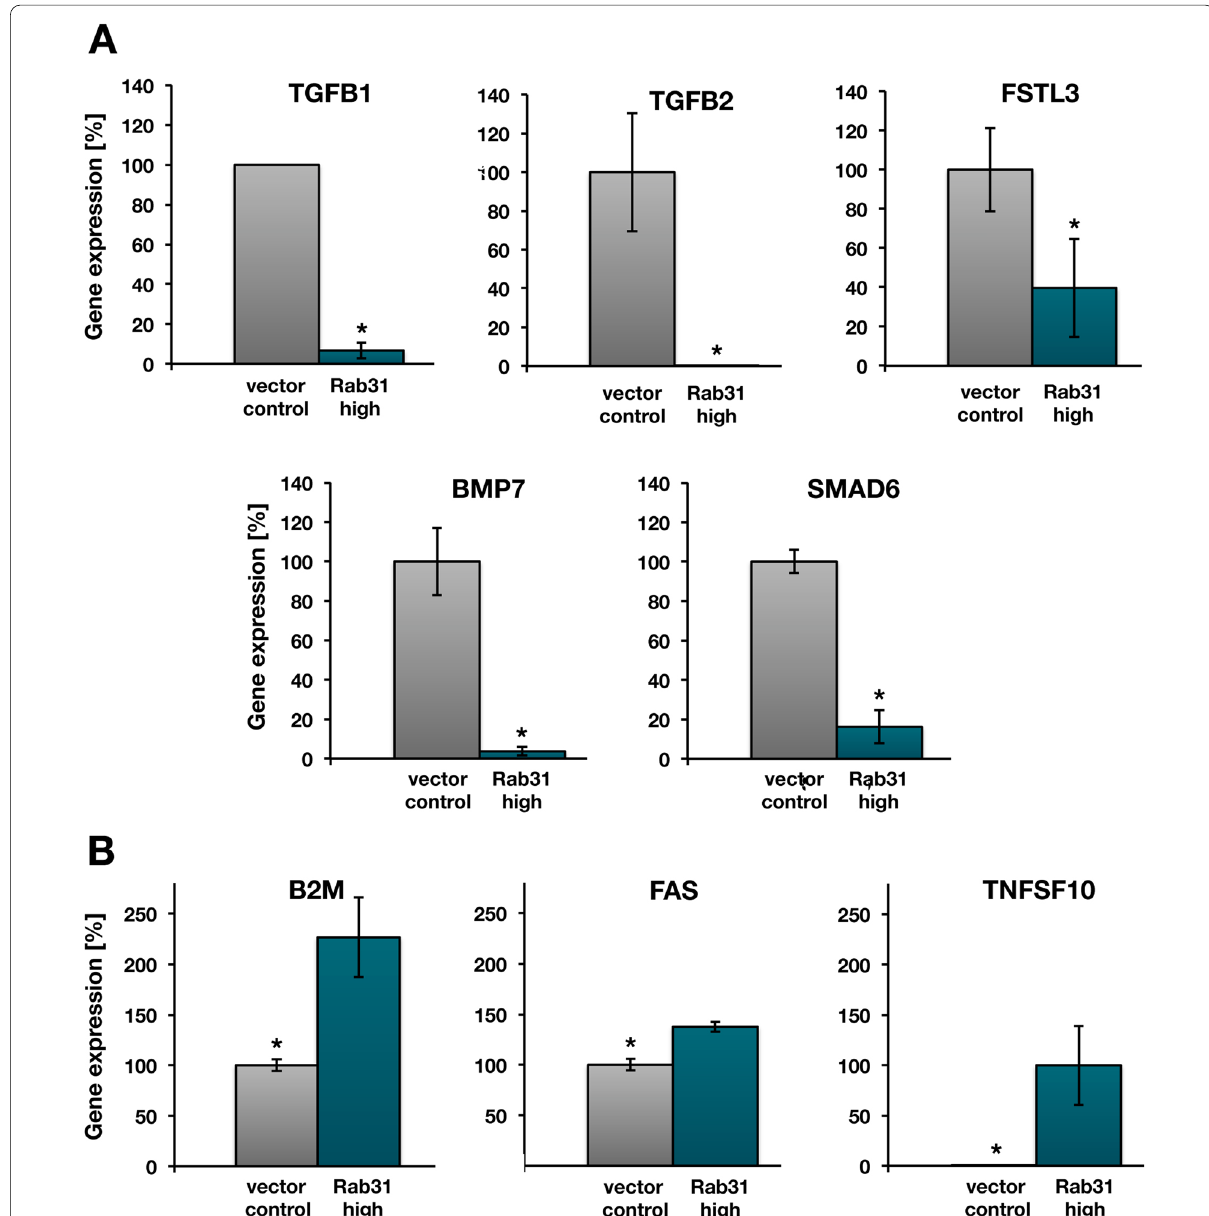
Fig. 8 Validation of differential gene expression in Rab31 overexpressing and vector control cells. A Validation of the significant, more than twofold, down-regulation of the five genes TGFB1 , TGFB2 , FSTL3 , BMP7 , and SMAD6 in Rab31 overexpressing and vector control cells. B Quantitative determination of the B2M , FAS , and TNFSF10 mRNA levels CAMA-1 cells. The significant, more than twofold up-regulation of the genes B2M and TNFSF10 in Rab31 overexpressing and vector control cells is in line with the profiler PCR array analyses (see Table 2). In case of FAS , although significant, only an approx. 1.4-fold increase is observed in Rab31 overexpressing over vector control cells. In all cases, except for TNFSF10 , the mRNA levels from vector control cells were set to 100% and the relative mRNA levels in the corresponding Rab31 overexpressing cells was calculated accordingly. For TNFSF10 expression, the mRNA levels of Rab31 overexpressing cells were set to 100%. All samples were normalized to HPRT1 expression level. Three experiments were performed in triplicates each. Statistically significant differences (p < 0.05) are indicated by an